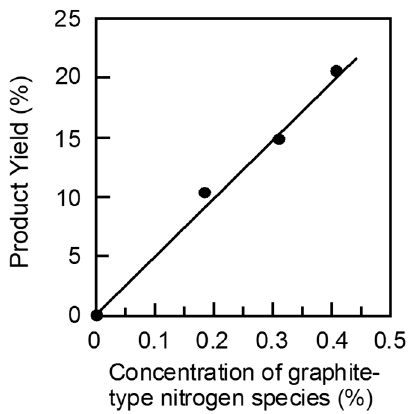
Figure 3. Plot of product yield in oxidation of HMF at 80 °C for 15 h against the amount of graphite-type nitrogen species [30].